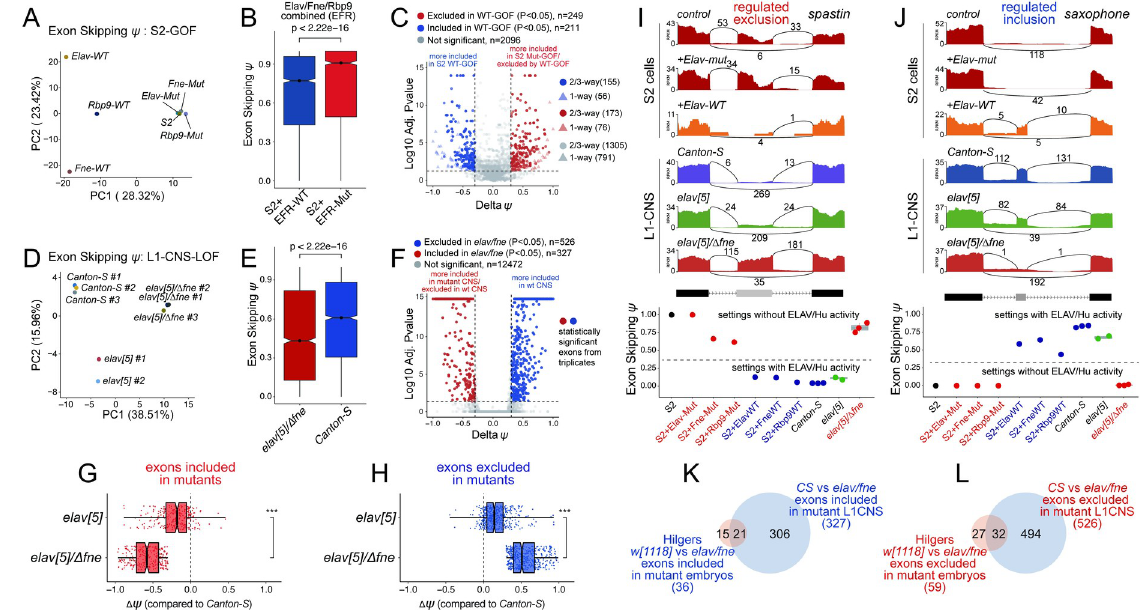
Fig 2. Overlapping activities of Drosophila ELAV/Hu RBPs control alternative cassette exon splicing. (A) Principal components analysis (PCA) of alternative splicing of cassette exons (percent spliced in, PSI/ ψ values) RNA-seq data from S2 cells transfected with wildtype (wt) or 3xRRM-mut (mut) versions of Elav, Fne and Rbp9 (i.e., EFR). (B) Fraction of exon skipping events in averaged S2 EFR-wt or EFR-mut datasets, treating the different ELAV/Hu RBP conditions as pseudo-replicates. (C) Volcano plot of alternative spliced cassette exon events in S2 cells following transfection of ELAV/Hu RBPs. Note that exons preferentially excluded by wt-ELAV/Hu RBPs correspond to exons that are preferentially included in control S2 cells and cells expressing mutant ELAV/Hu RBPs, and vice versa . rMATs will calculate P-values without replicates [53], but the values determined from replicate data are more confident. Thus, we distinguish exons with similar responses between 3, or across all three ELAV/Hu datasets. (D) PCA of cassette exon splicing in L1-CNS RNA-seq data from Canton-S , elav mutant, and double elav/fne mutants. (E) Fraction of exon skipping events in elav/fne mutant and Canton-S L1-CNS. (F) Volcano plot of alternatively spliced cassette exon events in Canton-S and elav/fne mutant L1-CNS. For effective visualization of volcano plots, a pseudocount of 1E-14 was added to all datapoints, to allow plotting of loci with P-value of 0; the actual values are shown in S1 Table. (G-H) The magnitude of splicing changes, for both included (G) and excluded (H) exons, is far greater in elav/fne double mutants than elav single mutants. ψ values in both mutants were calculated relative to Canton-S . (I) Example of a novel exon exclusion target of ELAV/Hu RBPs. (J) Example of a novel exon inclusion target of ELAV/Hu RBPs. (K-L) Comparison of statistically significant cassette exons in dissected L1-CNS, with those annotated from whole embryos